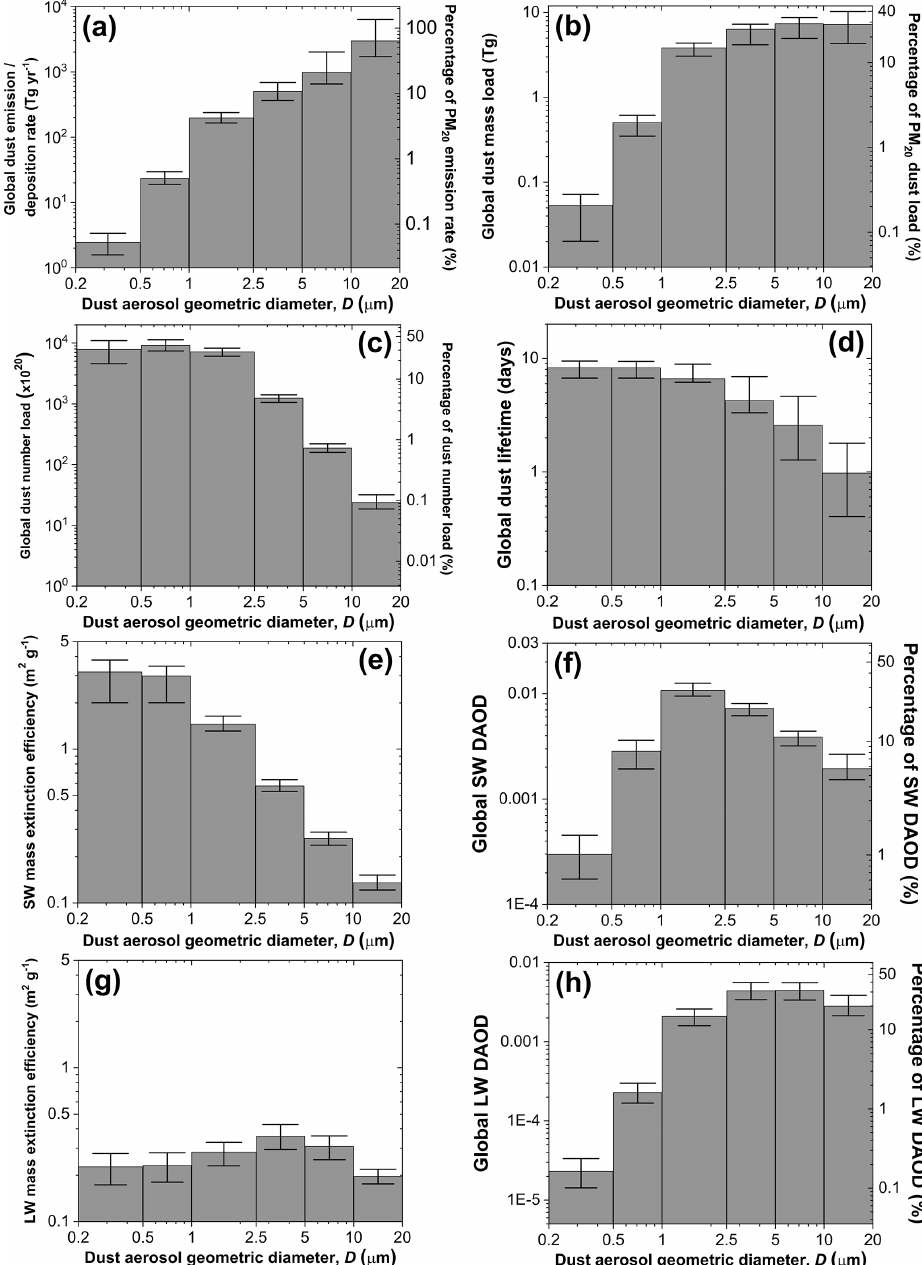
Figure 5. Size-resolved properties of the global dust cycle. Shown are the size-resolved (a) global dust emission rate (which equals the global dust deposition rate), (b) global dust loading in terms of mass per size bin, (c) global dust loading in terms of number of particles per size bin, (d) global dust lifetime, (e) dust mass extinction efficiency at 550nm, (f) global DAOD at 550 nm, (g) dust mass extinction efficiency at 10µm, and (h) global DAOD at 10µm. The right axis of panels (a) , (b) , (c) , (f) , and (h) shows the fraction of each dust cycle property that is accounted for by each size bin, which was obtained by dividing the simulated quantity in each bin by the median total for all bins. For panels (e) and (f) , we used the constraint on extinction efficiency at 550 nm from Kok et al. (2017); for panels (g) and (h) , we obtained a constraint on extinction efficiency at 10µm following the methodology of Kok et al. (2017), using probability distributions of dust shape descriptors obtained by Huang et al. (2020), and setting the real index of refraction to 1.70 ± 0.20 and the logarithm of the imaginary index to − 0.40 ± 0.11 based on a compilation of measurements by Di Biagio et al. (2017). Error bars denote 1 standard